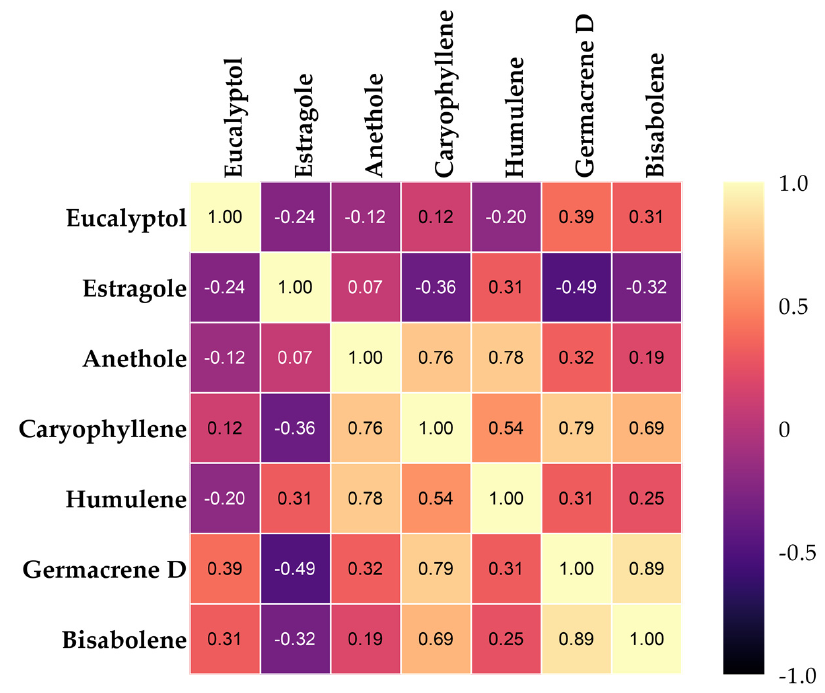
Figure 5. Heat map clustering of essential oil compounds corresponding to the treatments.